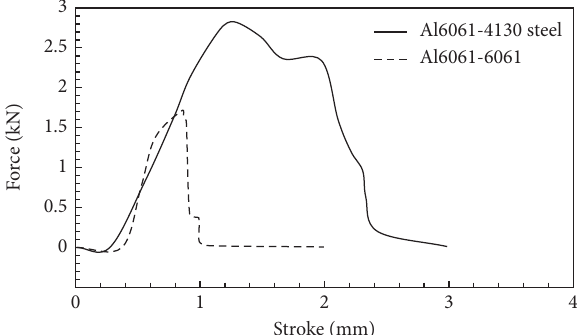
11: Load-stroke curve of the push-pin tests for Al6061-4130 steel and Al6061-6061 build (redrawn from